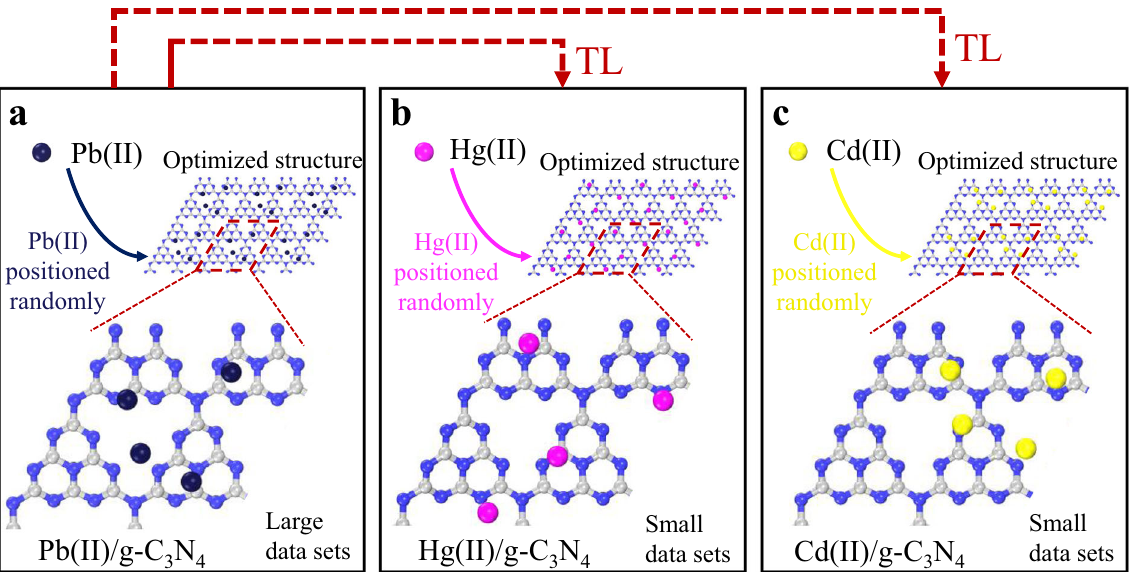
Fig. 1 Schematic model of adsorption process towards HMIs on the surface of g-C 3 N 4 . ( a ) Pb(II), ( b ) Hg(II), and ( c ) Cd(II). The Pb(II) (black atoms), Hg(II) (pink atoms), and Cd(II) (yellow atoms) were adsorbed randomly at the arbitrary sites of optimized g-C 3 N 4 . The dataset of Pb(II)/ g-C 3 N 4 contains 7000 DFT-based adsorption energies ( Δ E ), with training from scratch, while Hg(II)/g-C 3 N 4 and Cd(II)/g-C 3 N 4 contain 700 DFT- based adsorption energies ( Δ E ) respectively, with training based on transfer